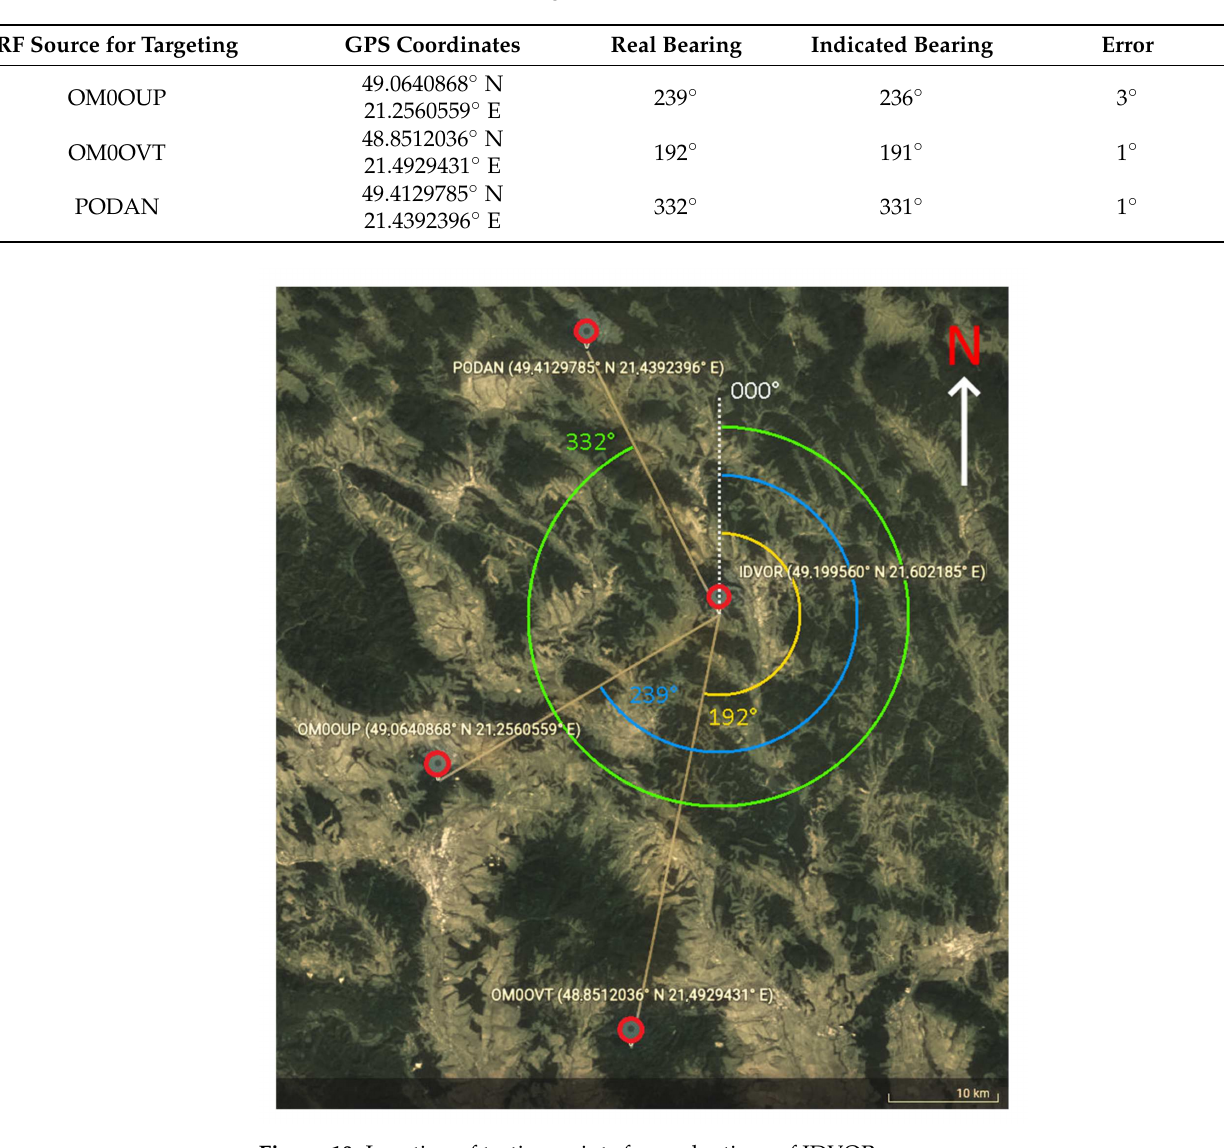
Table 2. Parameters for testing and evaluation of IDVOR.